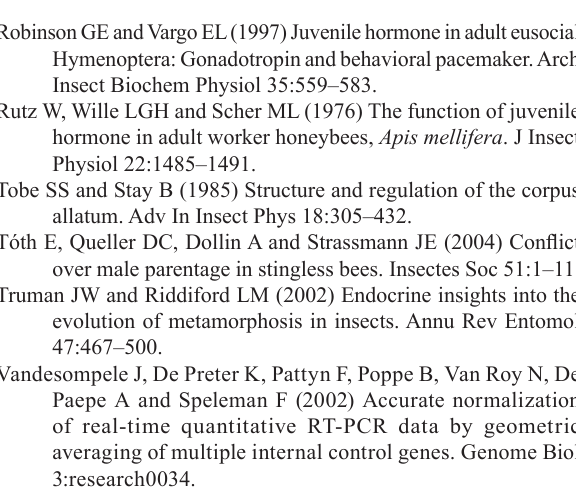
Figure S1 – Mathematical model used for calculation of normalized expression quantities (NRQ) with two reference genes in